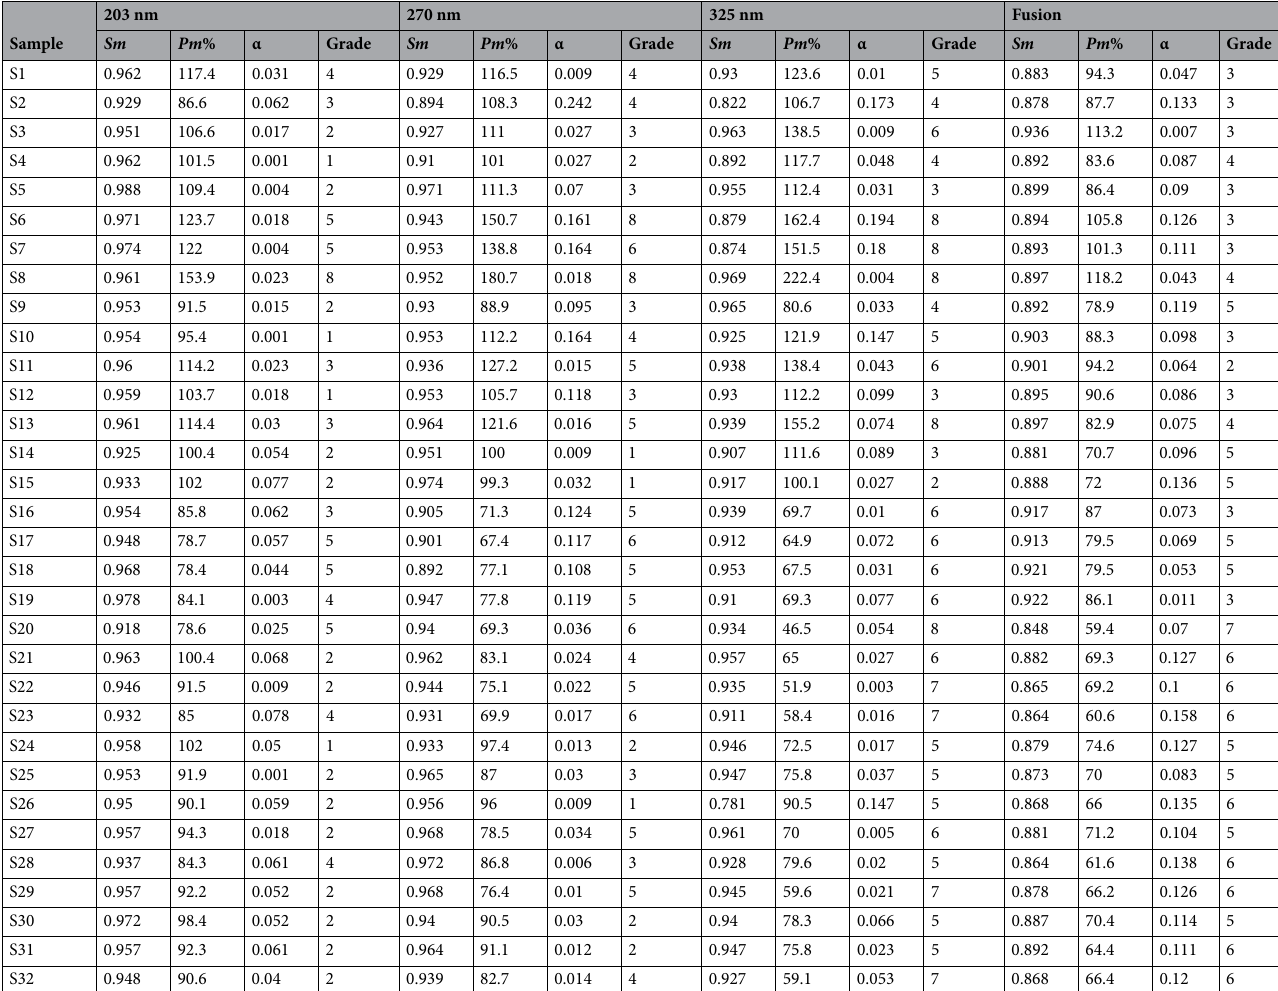
Table 3. The evaluation results obtained from ALQFM of 32 batches of P. notoginseng